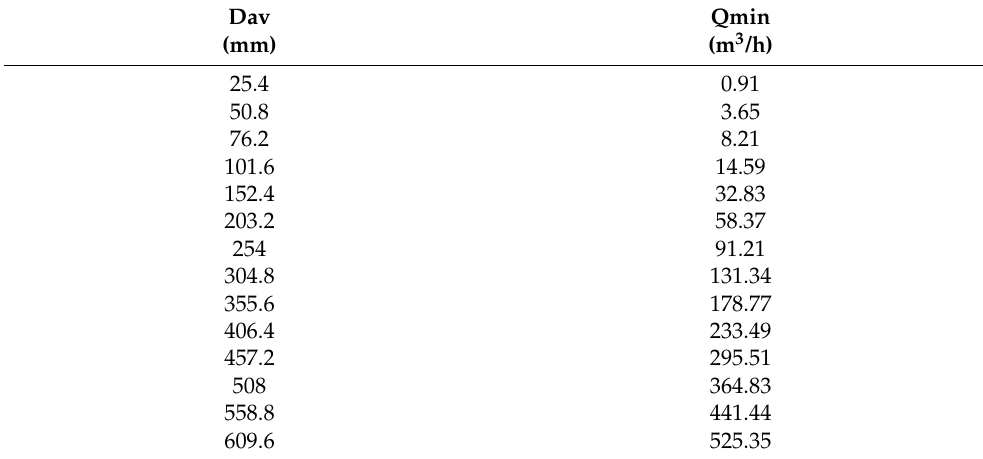
Table 2. Minimum flow rate for each available